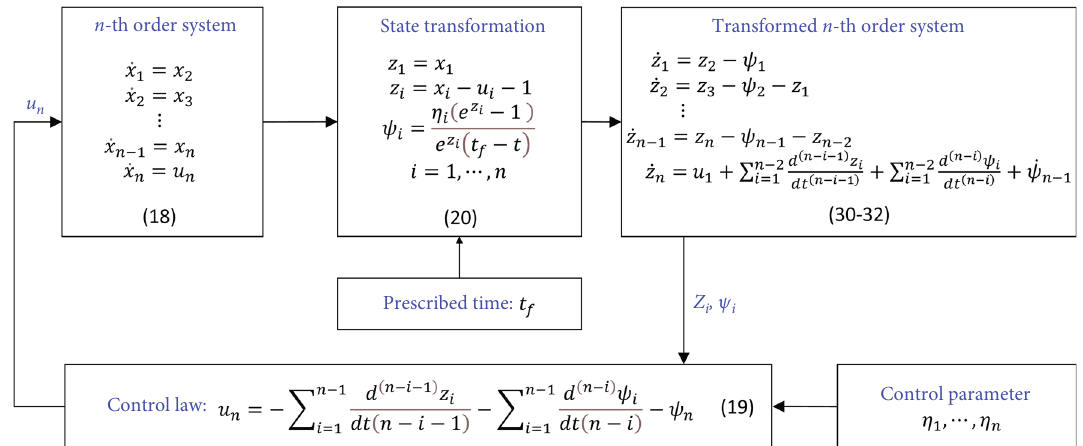
Figure 1: Control structure diagram of the proposed n -th order arbitrary time convergence